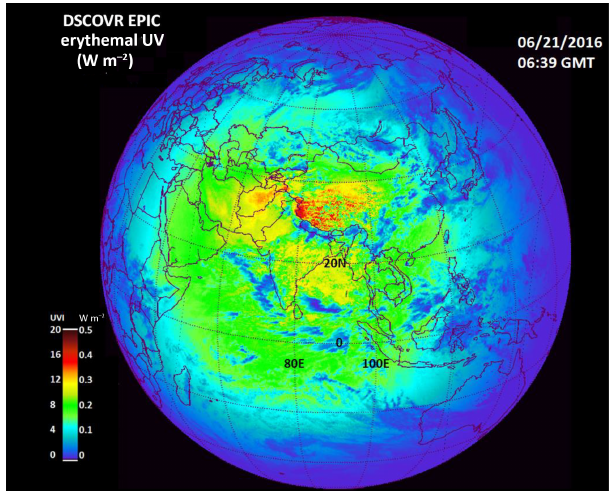
Figure 21. Erythemal UV irradiances centered over the Indian Ocean on 21 June 2016 showing high values over the Himalayas with the UV index exceeding 14. UV levels are moderated by par- tial cloud cover reflection of radiation back to space. Solar noon is at 80.25 ◦ E.